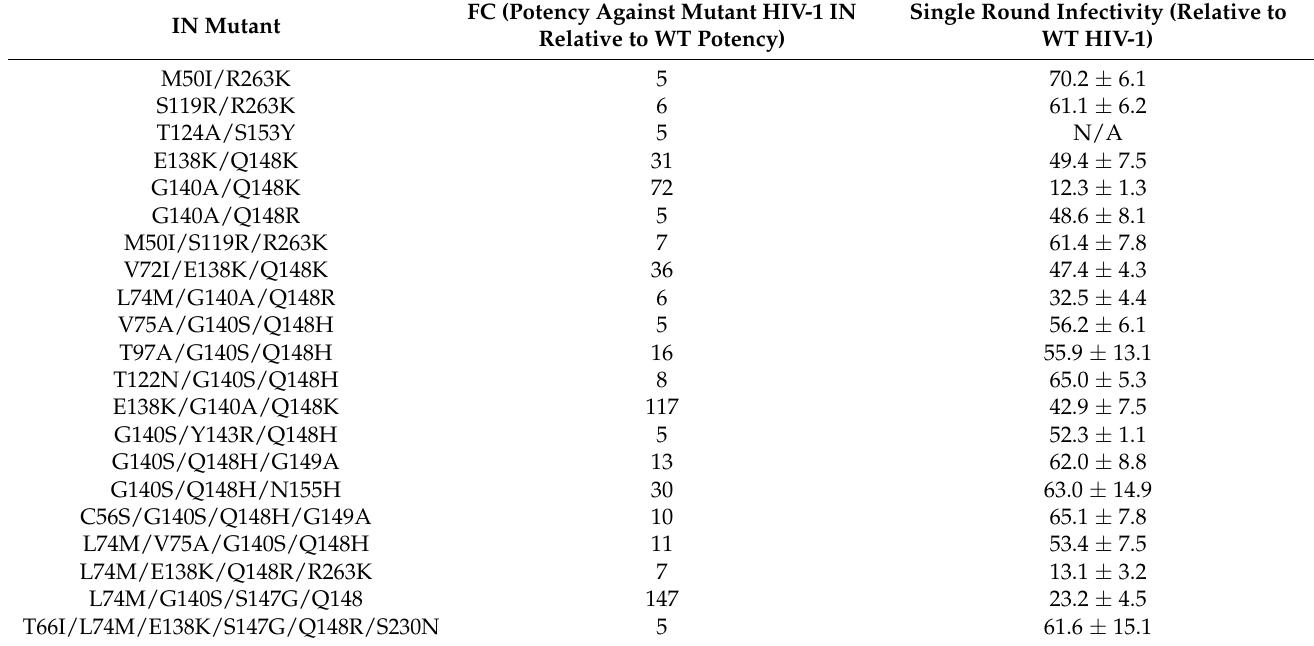
Table 4. IN mutants selected against bictegravir (BIC). IN double and complex mutants that have been selected against BIC using in vitro selection studies or identified from IN susceptibility assays are shown. The FCs of the potencies of BIC against the IN mutant relative to its potency against WT HIV-1 are also included as are the single round infectivity of the IN mutant relative to WT HIV-1. FC (Potency Against Mutant HIV-1 IN Mutant